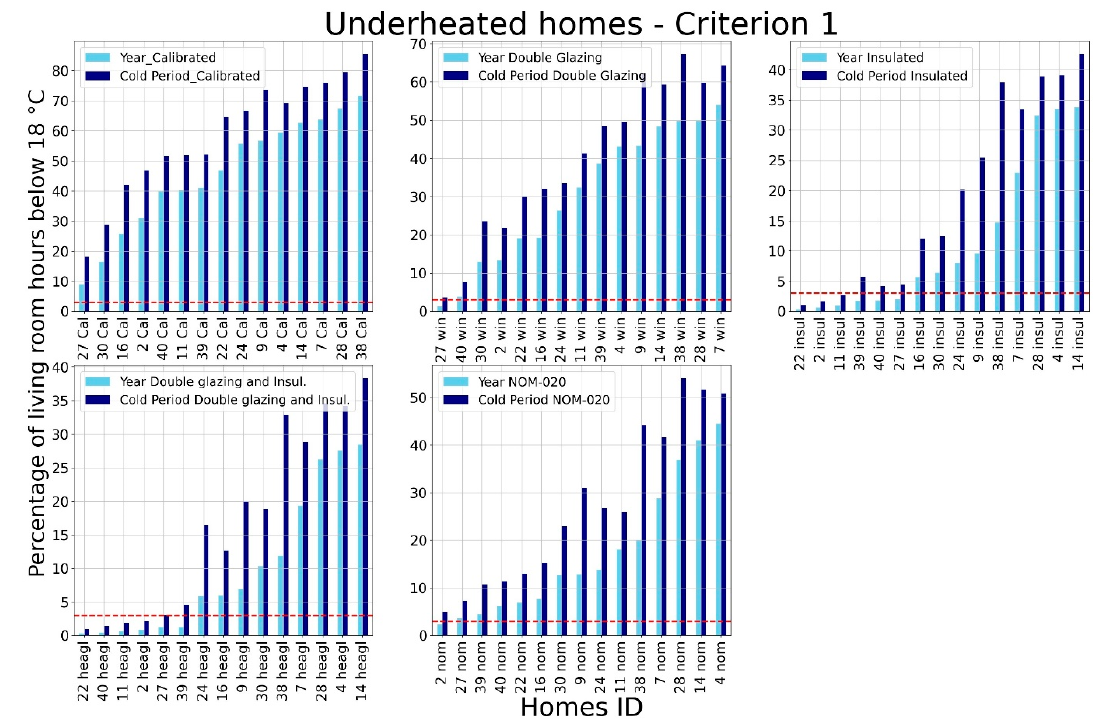
Figure 13. Percentage of underheated hours according to our criterion 1 after simulations.